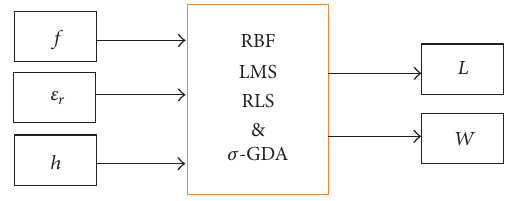
Figure 2: Synthesis of